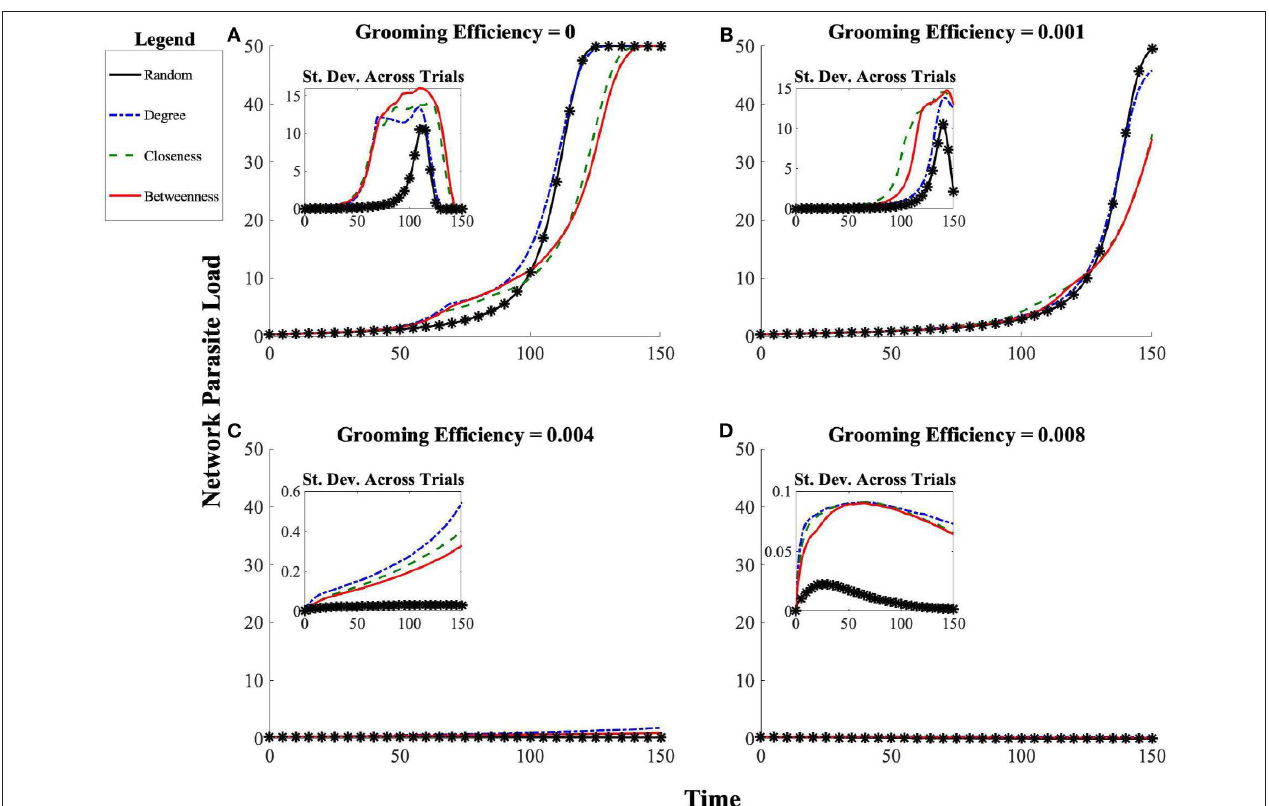
FIGURE 3 | Progression of network ectoparasite load over time for each social affiliation strategy (random, betweenness, closeness, and degree) across grooming efficiencies (A) g = 0, (B) g = 0.001, (C) g = 0.004, (D) g = 0.008. The initial introduction of ectoparasites to the network occurs at t = 0. There is substantial fluctuation in ectoparasite burden early on in the time course of the epidemics. We expect and see greater consistency in the trajectory from the point at which most individuals have sustained a moderate ectoparasite load until total population saturation. The standard deviation across 100 simulated trials is shown in the inset. Note that even in cases of maximal outbreak ( g = 0 and g = 0.001), social organization has an impact on the timing of the